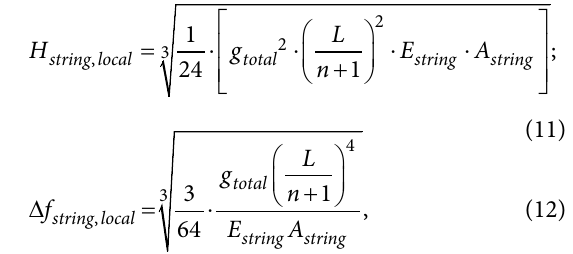
Calculations are provided for two load cases: when the load is applied by using cross beams and when the load is transmitted directly to the string. The versions of con- struction are presented for each load case, for example, a hanging road or bridge with a deck and without a deck.